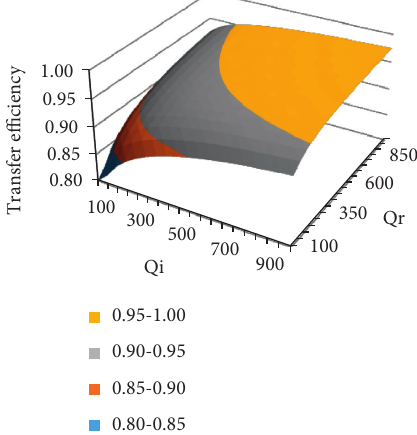
Figure 5: Maximum theoretical transfer efficiency characteristic with k